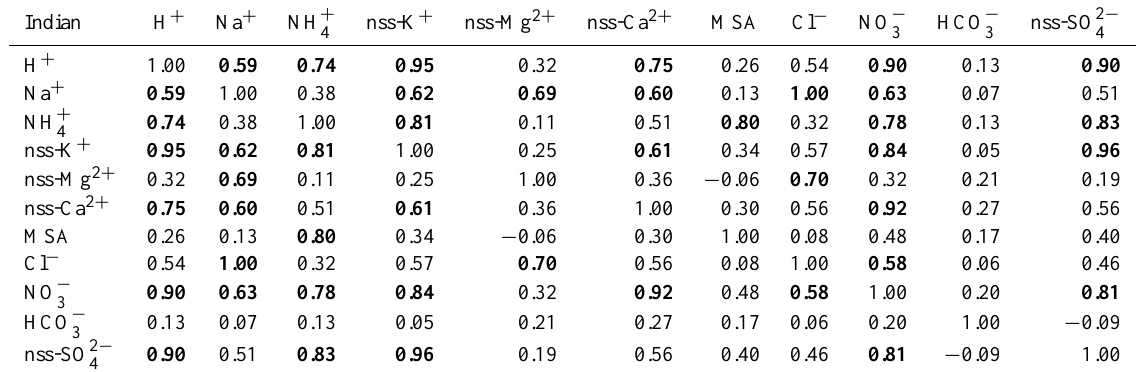
Table 4. Correlation coefficients for rainwater ionic components in the Indian trajectory group. ∗ Bold font indicates that the correlation is significant at 95% level.